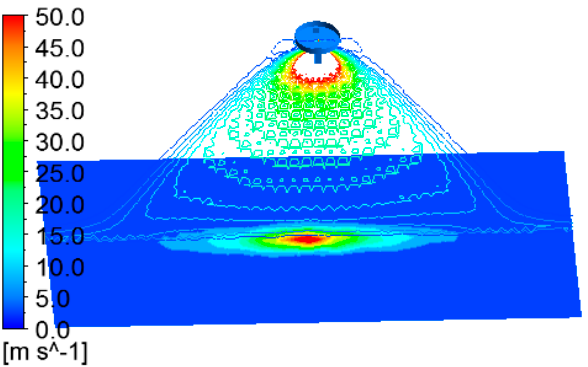
Figure 11. Plane vertical spraying: velocity contours in the plane X = 0 overlaid with static coating film thickness on the target.